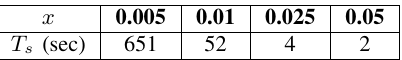
( P ) , δ (1) ( P ) , - - - graphs of H C